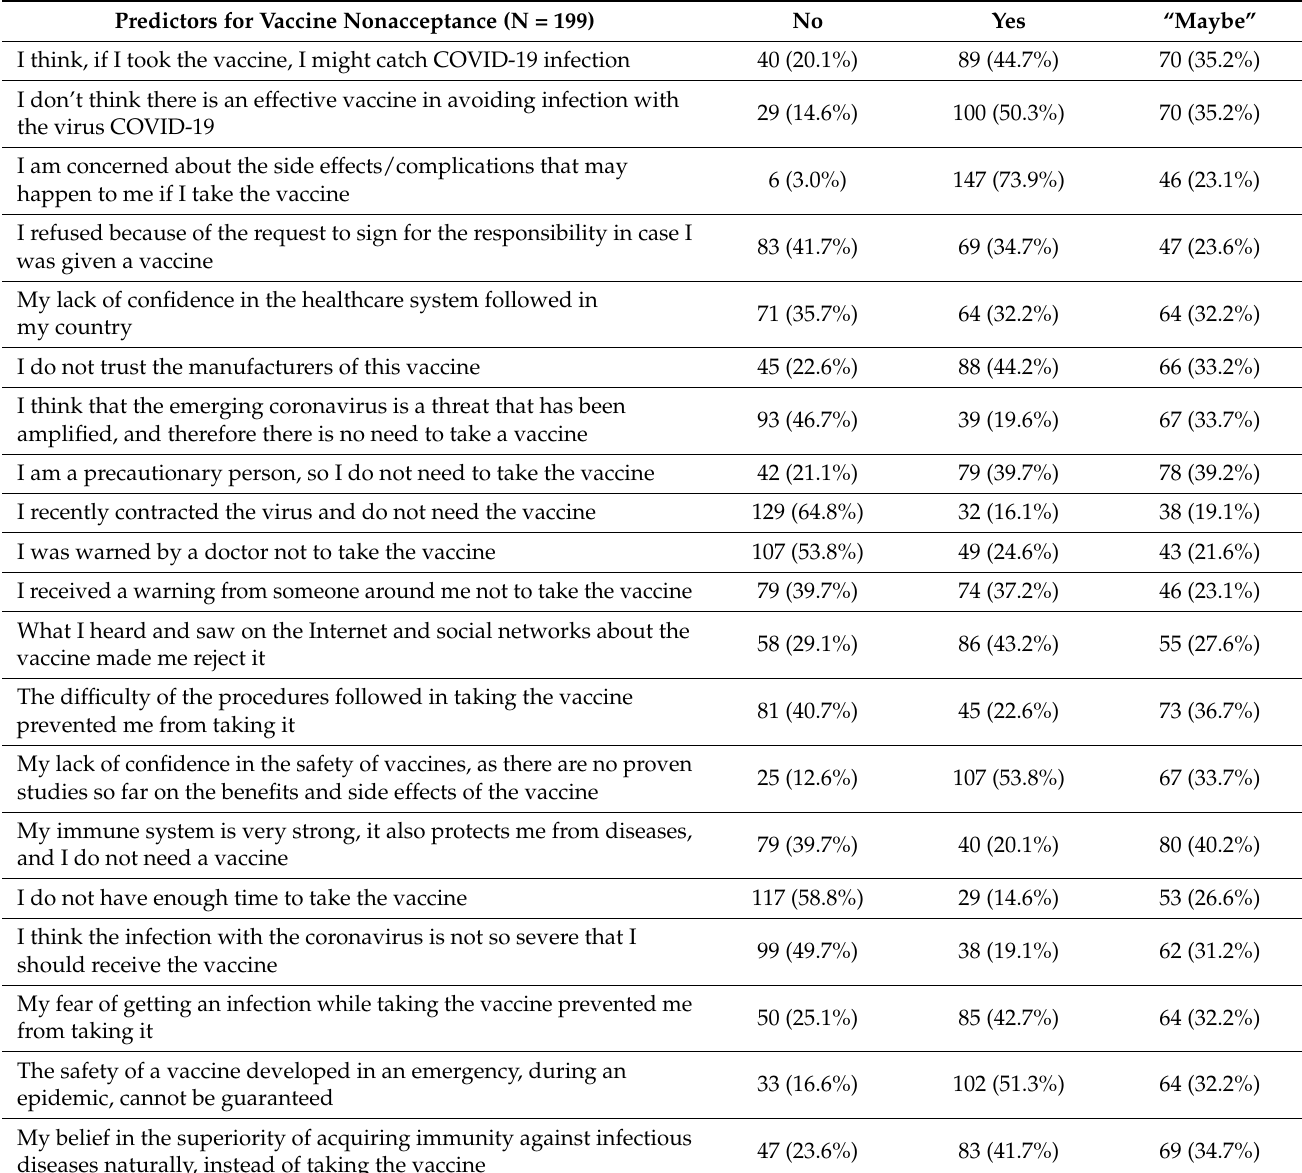
Table 3. Predictors of vaccine nonacceptance among nonaccepted HCWs (N =